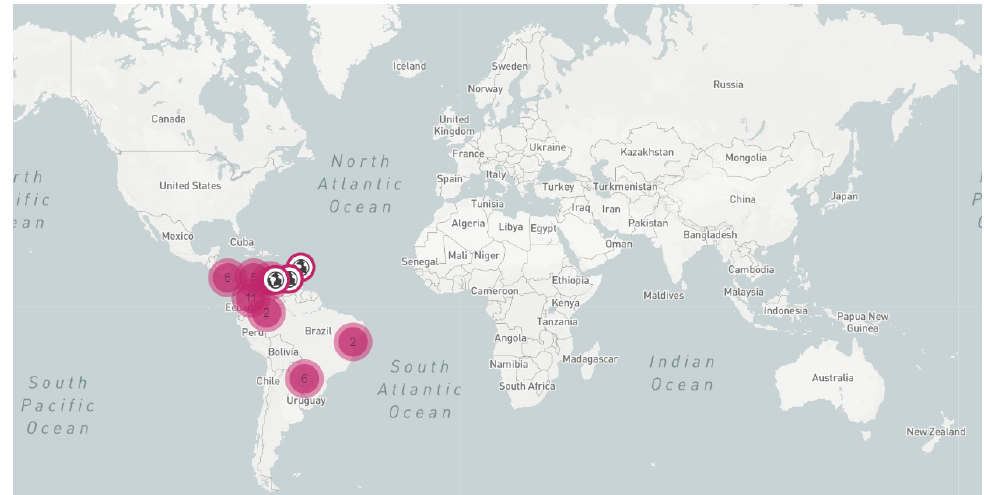
Figure 3. Map showing the current geographical distribution of CFSD according to a global literature search using Google Scholar, using search terms ‘mandioca couro de sapo’, ‘yuca cuero de sapo’, and ‘cassava frogskin’. Information from internal CIAT annual reports is included. The interactive map and links to the historical reports are available at: https://pestdisplace.org/embed/news/map/disease/5 [28]. The information was last accessed on 20 April 2022.